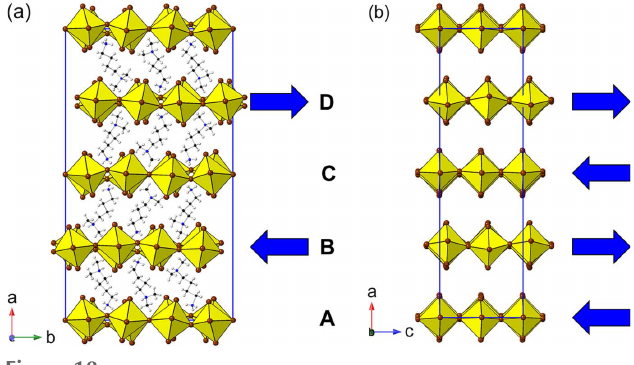
Figure 18 The complex structure of [C 6 H 18 N 2 ]PbBr 4 (1963067) ( a ) viewed down c , showing the complex C-mode tilt/distortion and effect of the unique (cid:6) 5 shift mode (note only the B and D layers are affected by this); ( b ) viewed down b , showing the effect of the common M 5 (cid:2) mode. The result of these superposed shifts is that the A and C layers are perfectly eclipsed (DJ) relative to each other, but all direct neighbouring layers are